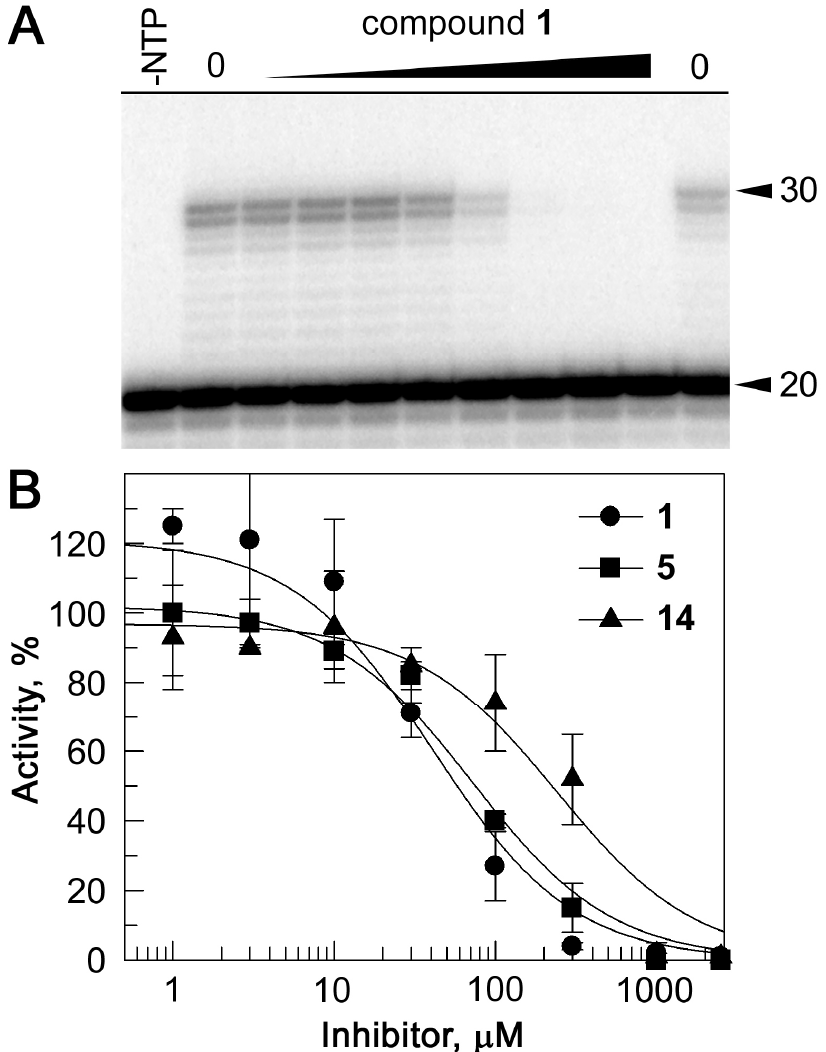
Figure 5. Titration of RdRp inhibitors. RdRp was pre-incubated with increasing concentrations of individual inhibitors, and its activity was measured after adding the RNA substrate and